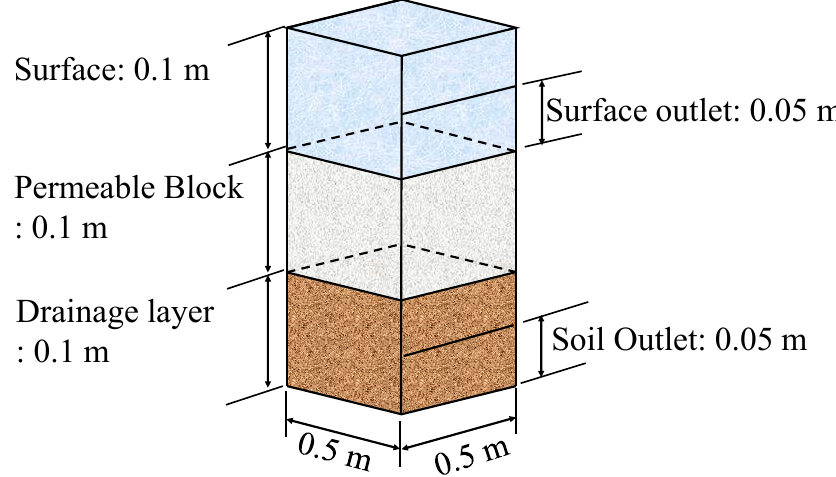
Figure 9. Properties of scaled model. Table 4. Results of scaled